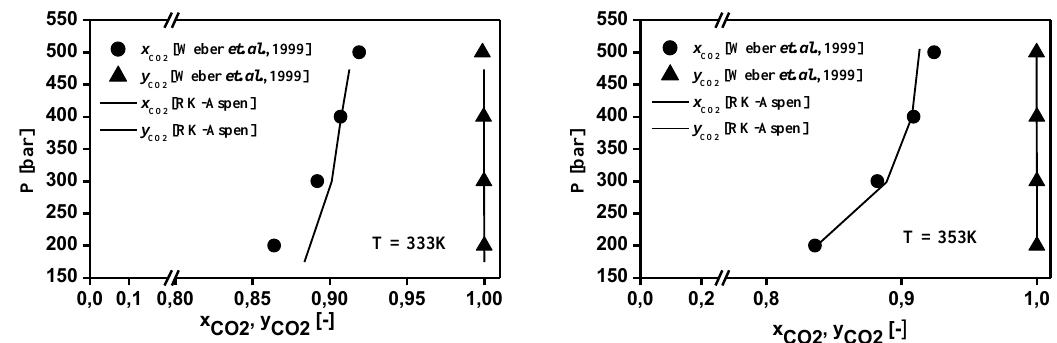
Figure 3. Experimental and predicted high-pressure phase equilibrium for the system squalene-CO 2 (Brunner et al., 2009).